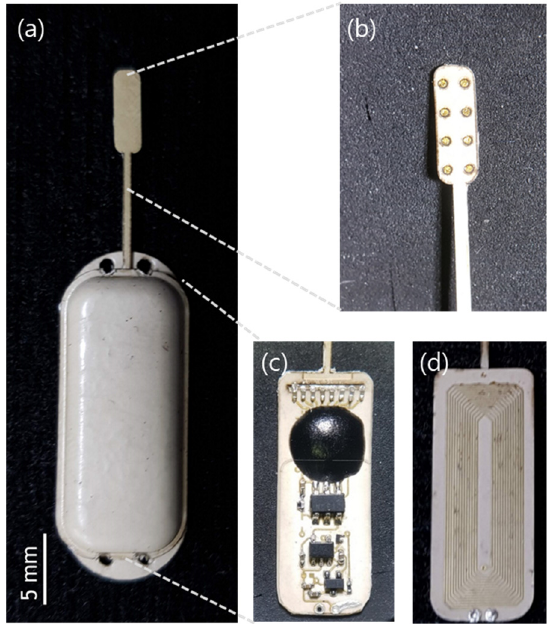
Figure 3. ( a ) Fabricated implantable neural stimulator; ( b ) Electrode part; ( c ) Circuit layer; and ( d ) coil layer in the